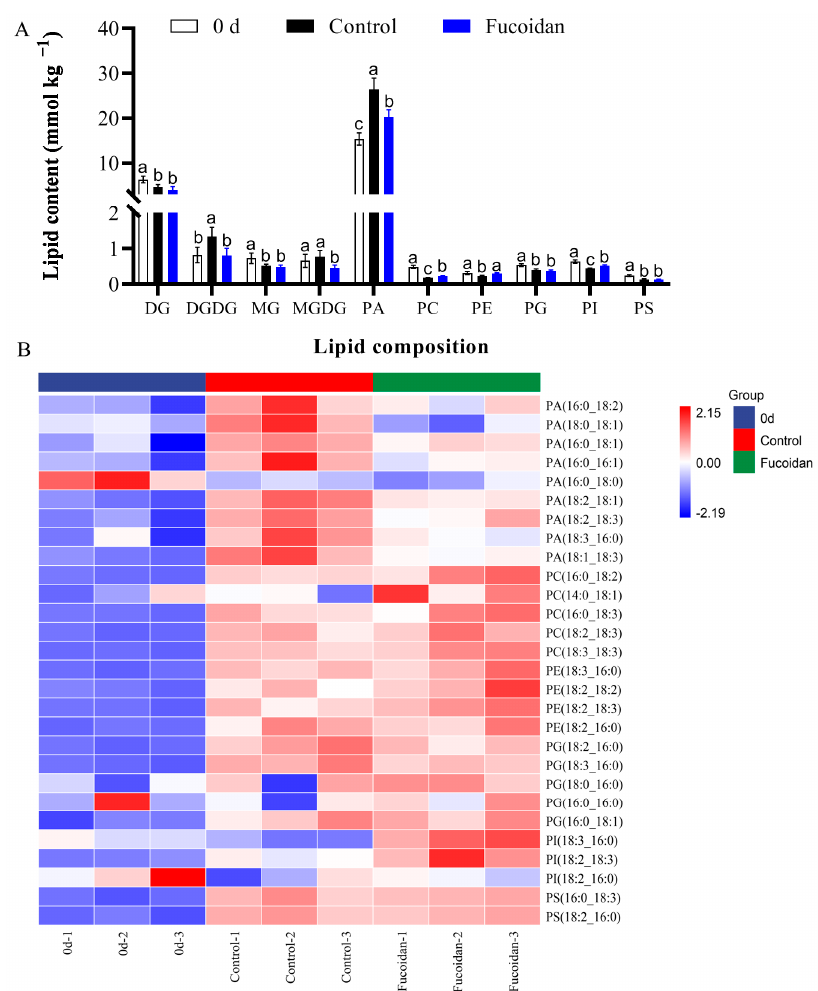
Figure 3. Changes in each phospholipid content ( A ) and each phospholipid species ( B ) in cucumber fruit at harvest (0 day) and in fucoidan-treated and control fruit after 12 d of storage at 4 °C. Values are marked as mean ± standard deviation (SD) of three replicates. Bars with same letter mean no significant differences at p < 0.05.